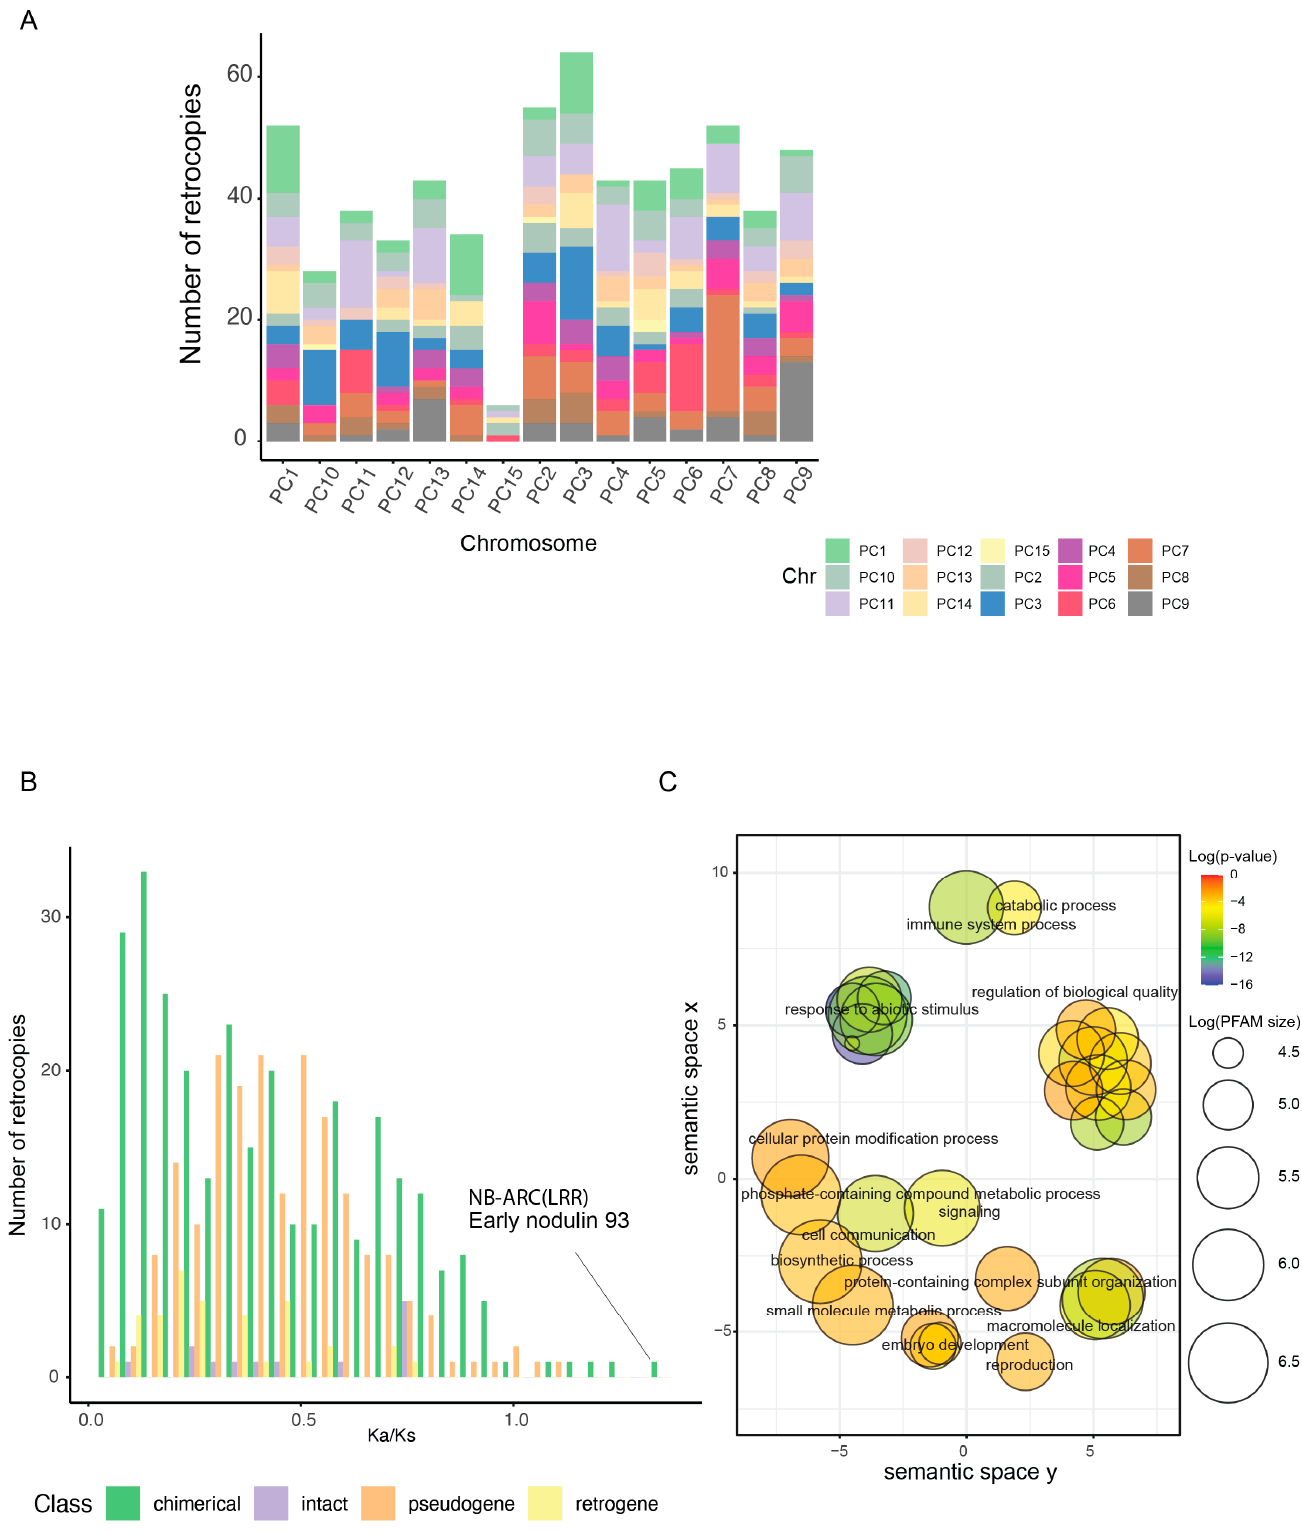
Figure 4. Retrogene identification and selection. ( A ) Genomic distribution of parental and retrogenes across 15 P. cineraria scaffolds (14 pseudochromosomes and one other scaffold). ( B ) The ratio of nonsynonymous substitutions to synonymous substitutions (Ka/Ks) of the parental to retrocopied genes for different classes of retrogenes. For Ka/Ks > 1, the Early nodulin 93 and NB-ARC genes are highlighted. ( C ) GO enrichment analysis of retrogenes displaying biological processes. Each sphere represents a GO term whose degree of enrichment is reflected in color on a − log 10 (P) scale.